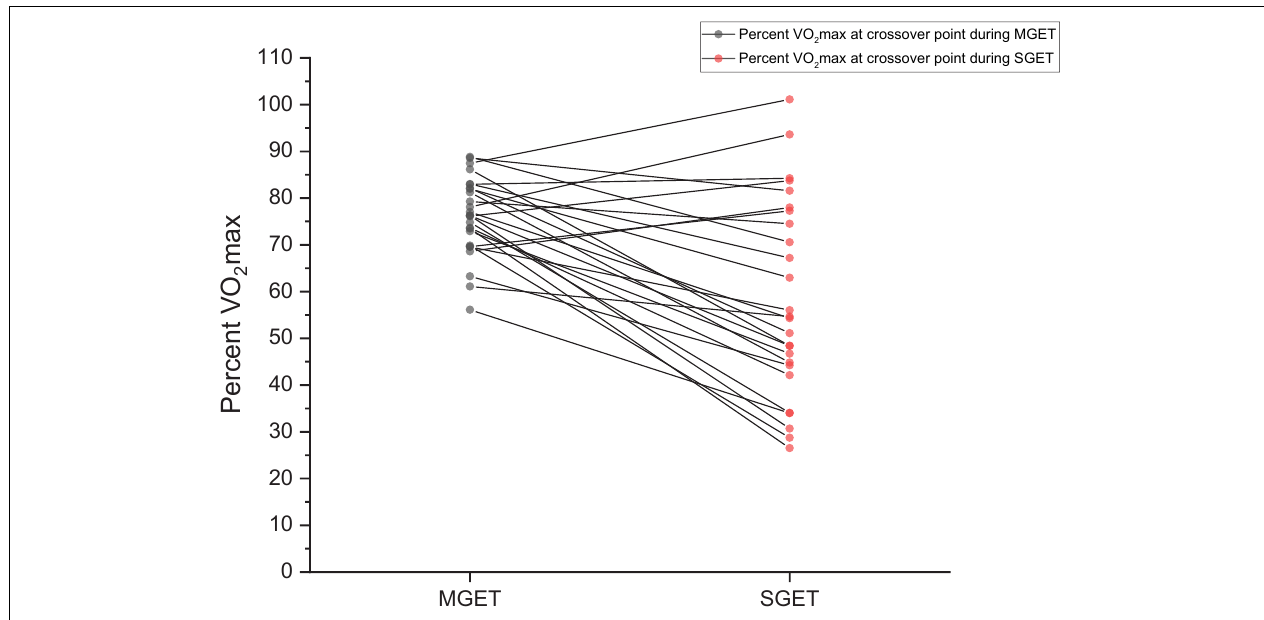
FIGURE 1 | Individual comparison of percent maximal oxygen consumption (VO 2 max) at crossover point during the maximal graded exercise test (MGET) and submaximal graded exercise test